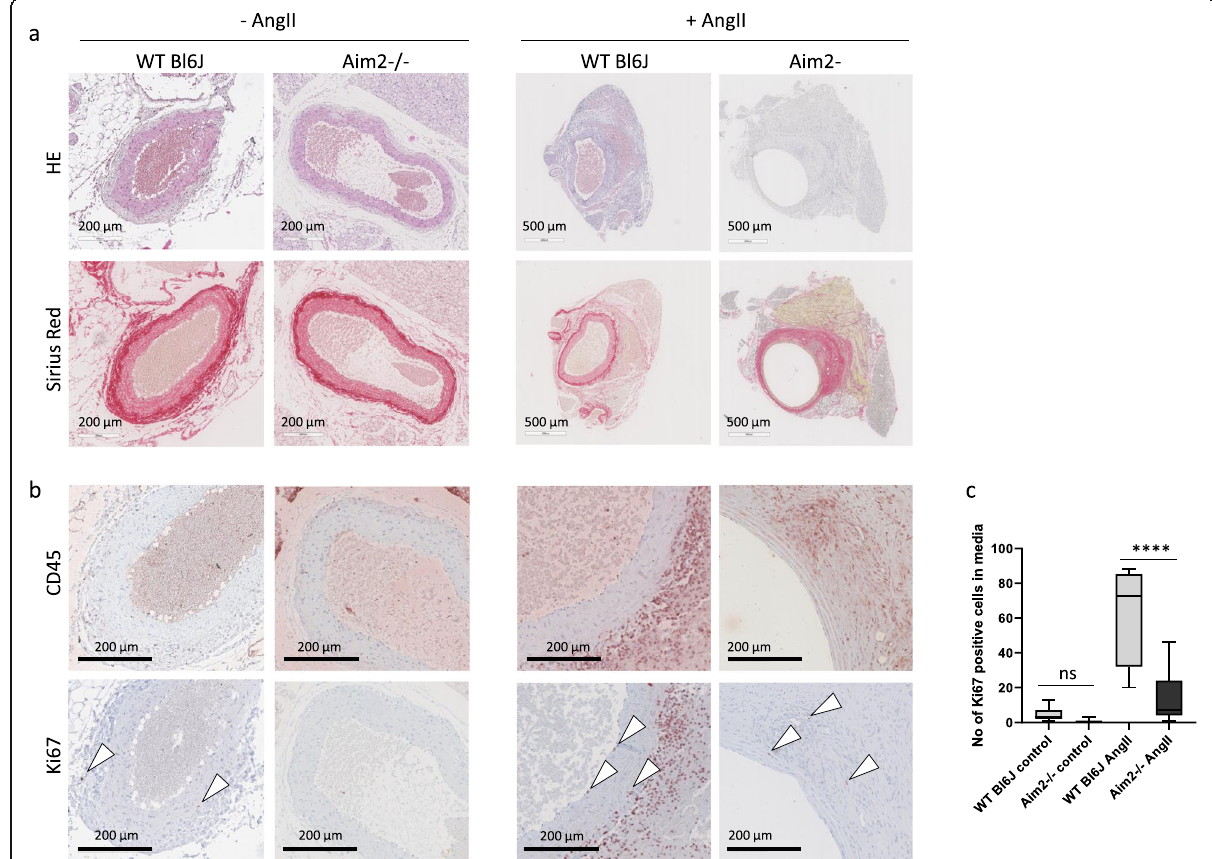
Fig. 5 Representative histological aortic sections derived from untreated and AngII infused mice. a Samples were stained with hematoxylin/eosin (HE) for morphological analysis and with Sirius Red for detection of collagens. b Immunohistochemical analysis of leukocyte infiltration (CD45) and proliferating cells (Ki67); n = 3 for WT - Ang II; n = 6 for Aim2 − / − − AngII; n = 4 for WT + Ang II; n = 6 for Aim2 − / − + AngII. c Quantitative analysis of proliferating cells (Ki67 positive) within the media of abdominal aortic regions. Proliferating (Ki67 positive) cells were counted in abdominal aortic sections of both, dilated and undilated samples. Shown is the mean and SD of WT control ( n = 7), Aim2 − / − control ( n = 6), WT + AngII ( n = 4), and Aim2 − / − + AngII ( n = 11) samples. Data were analyzed. by one-way ANOVA. ns: not significant, ****: P <